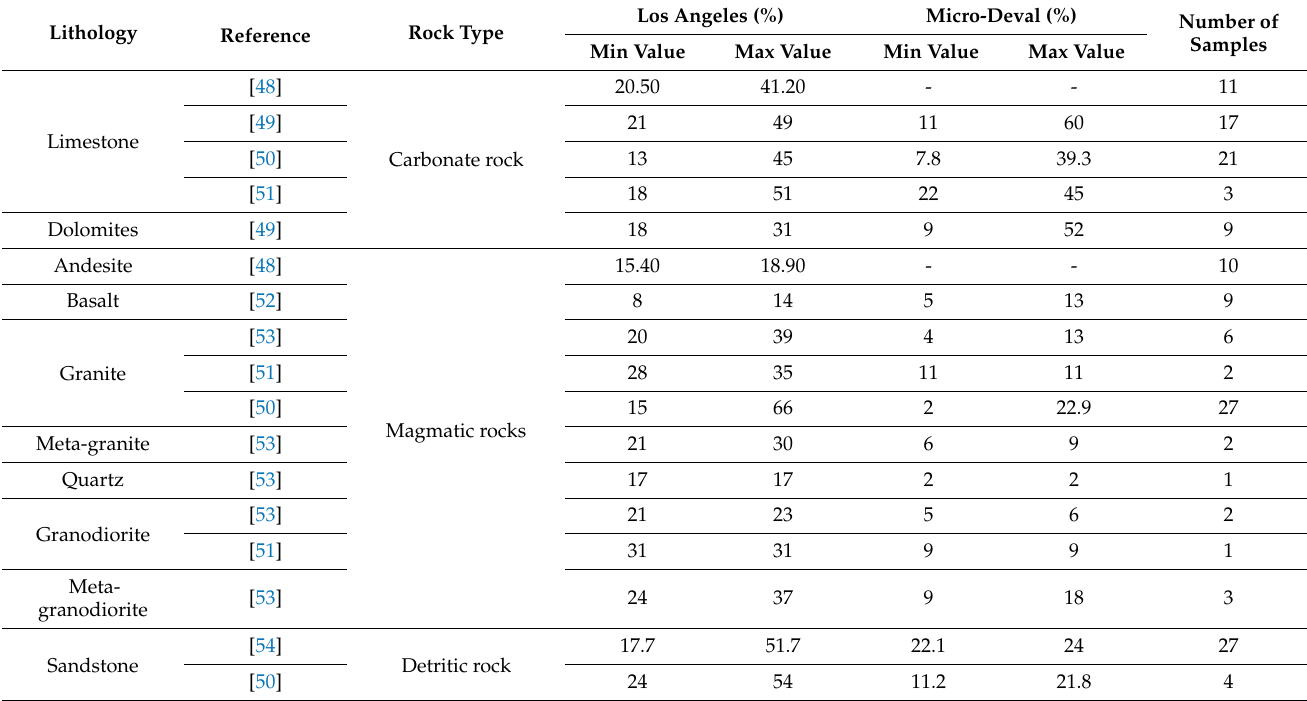
Table 5. Mechanical parameters of rocks according to the